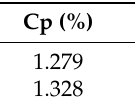
Table 8. Conditions for the determination of the stability of the suspension.